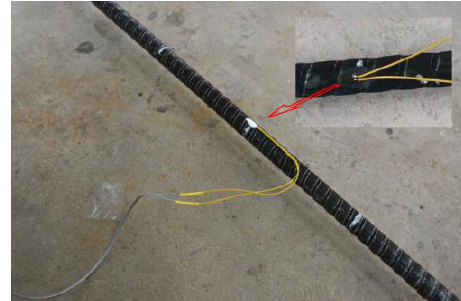
Figure 3. Details of strain gauges.